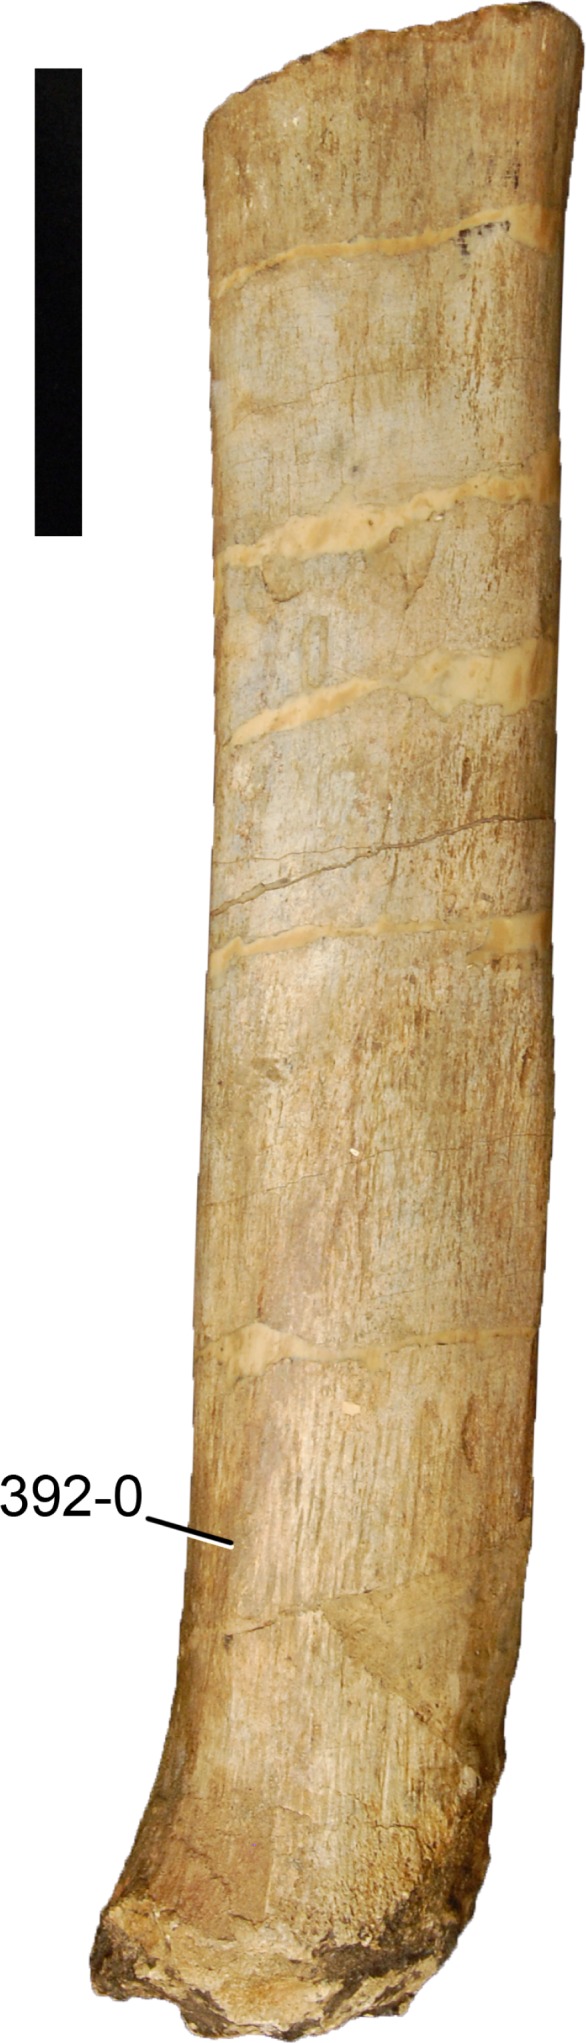
Distal half of radius of Dyslocosaurus polyonychius AC 663.Note the very weak ridges for the articulation with the ulna (C392-0). Scale bar = 10 cm.